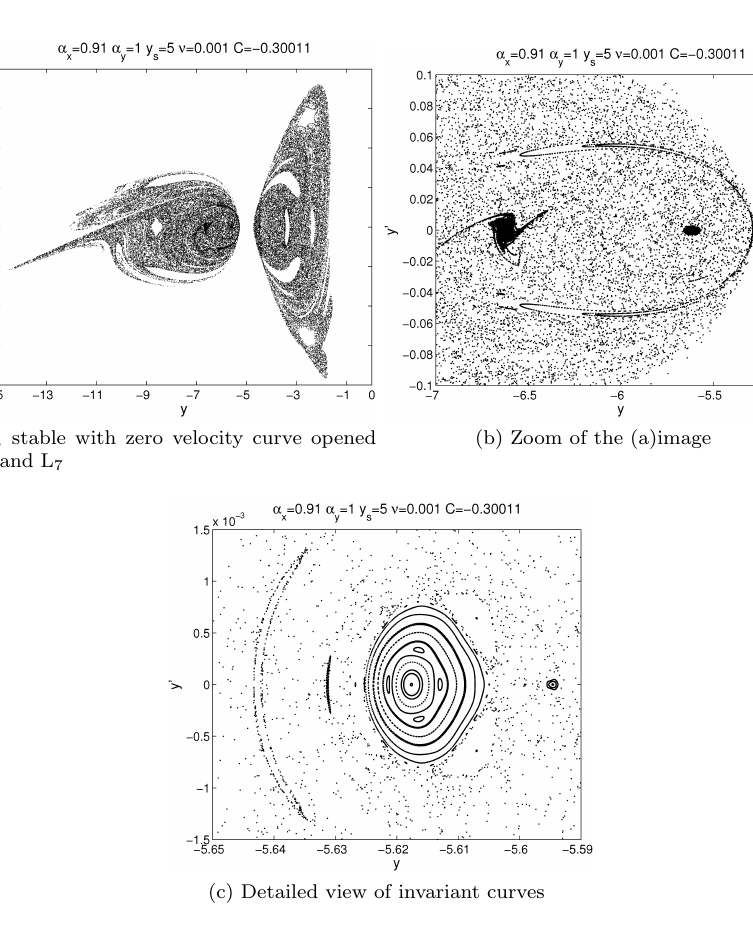
Fig. 8. Returns of the Poincar´e map with starting values on the y axis below the Lagrange point. L 3 is a stable equilibrium point and the zero velocity curve has opened on L 6 , and L 7